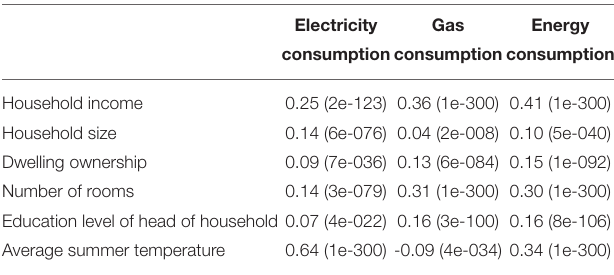
TABLE 5 | Spearman correlation coefficients of household characteristics and household energy consumption; p -values are shown in parentheses.